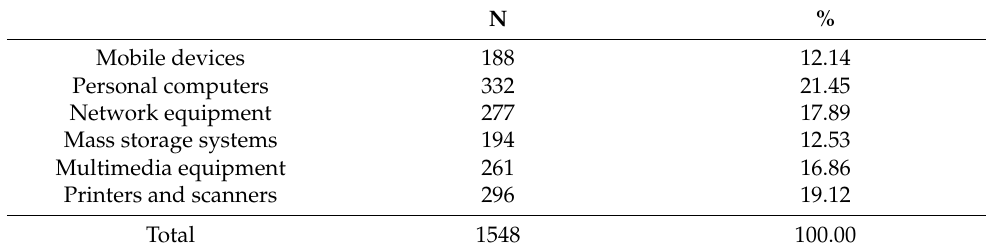
Table 2. IT devices that give the greatest energy savings.